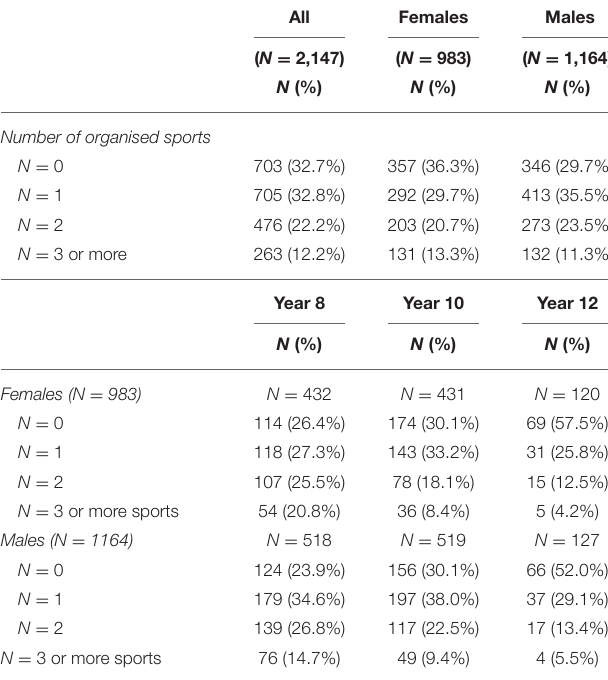
TABLE 3 | Summary of the number of organised sports (current/past 12 months only) by gender and year level.